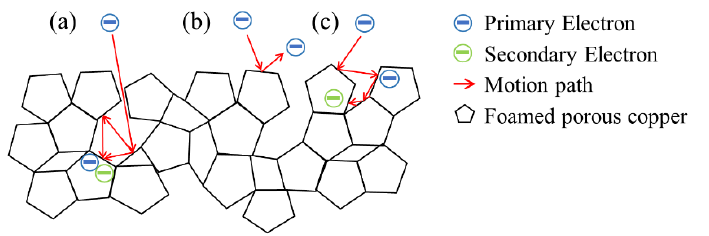
Figure 8. Schematic example of SEE from foamed porous copper. ( a ) Primary electron impact hole trap structure. ( b ) Primary electron impact top of the surface. ( c ) Primary electron impact uneven 3D surface.